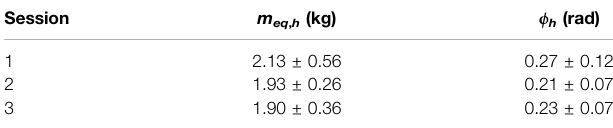
TABLE 2 | Identi fi ed masses and JMs for each session. Session